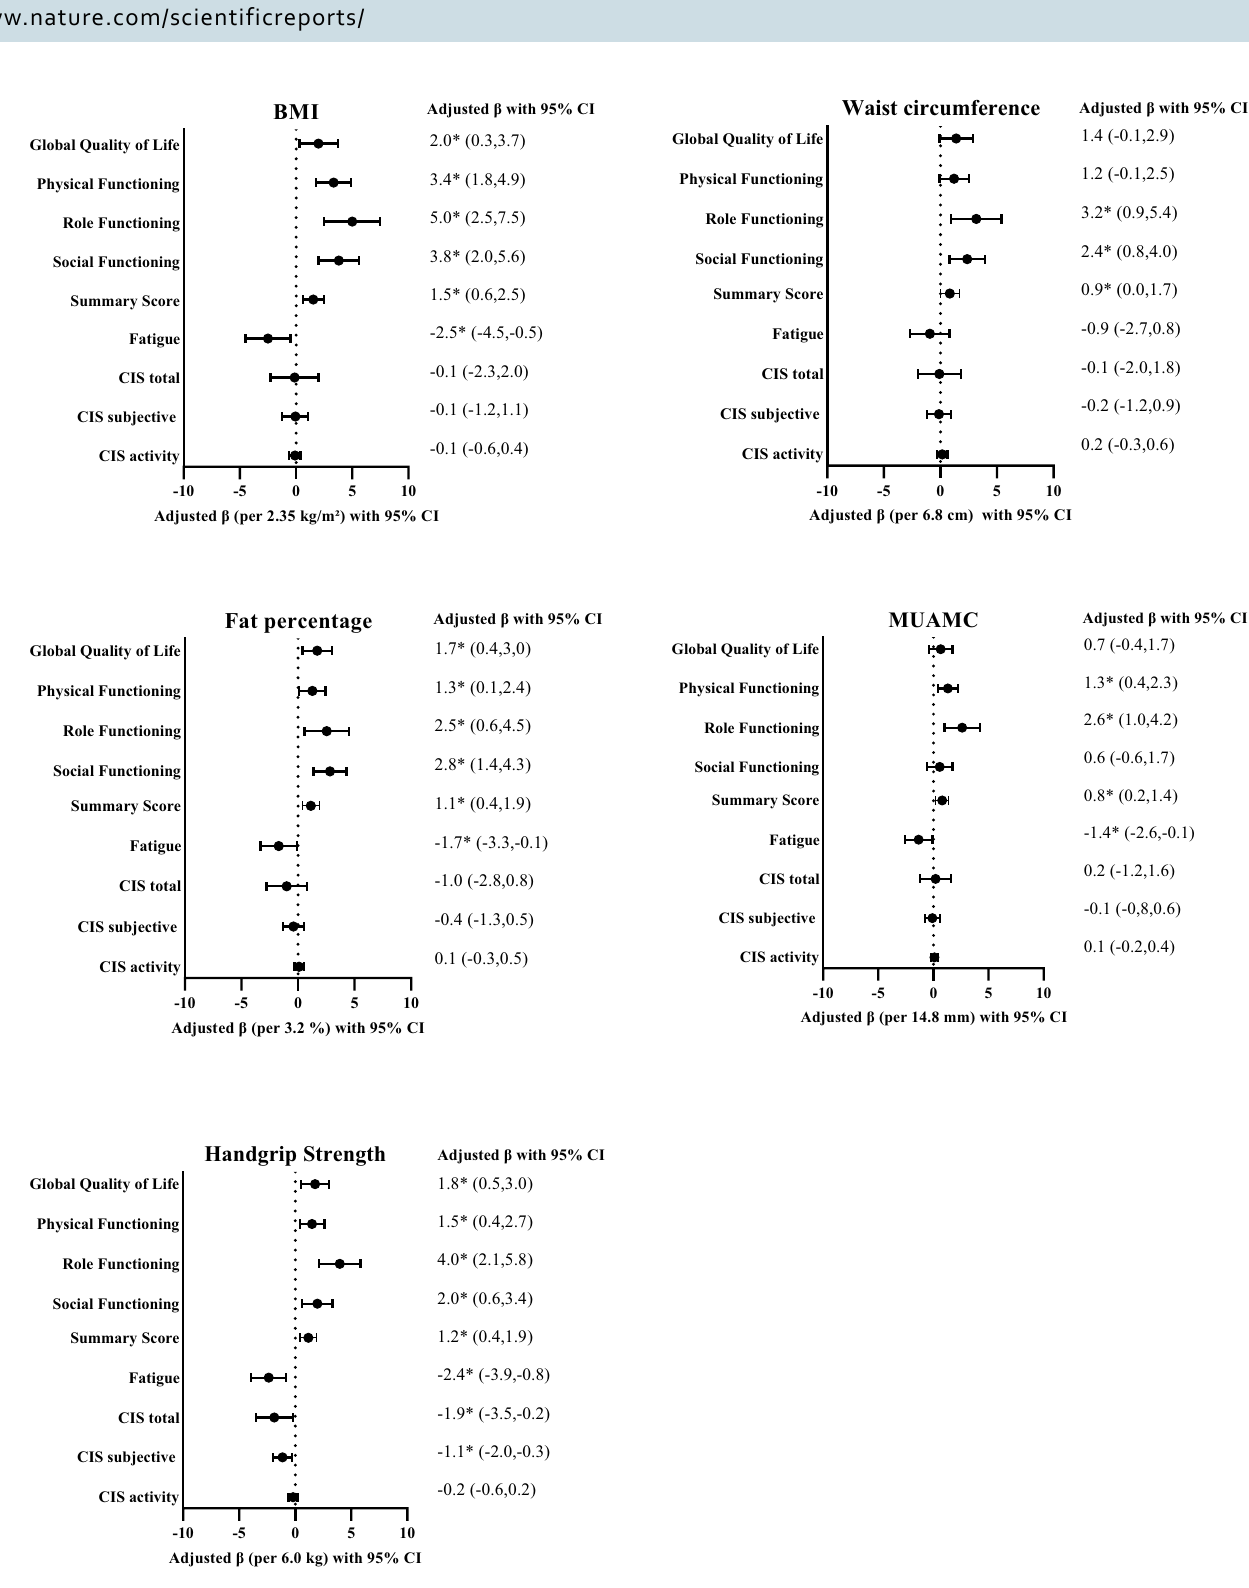
Figure 4. Forest plots showing the confounder-adjusted betas (β) and 95% confidence intervals (CI) for the overall longitudinal associations of the five body composition measures (BMI, waist circumference, fat percentage, MUAMC, and handgrip strength) in relation to health-related quality of life and fatigue outcomes in stage I–III colorectal cancer survivors followed-up from 6 weeks to 2 years after treatment. *Indicates statistically significant associations (p < 0.05) between body composition measure and health-related quality of life and fatigue